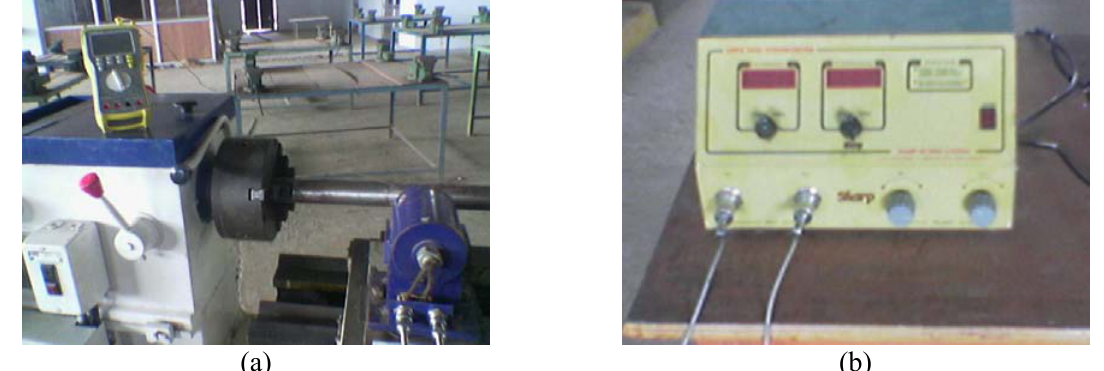
Fig. 1. Experimental setup (a) Turning tool dynamometer (b) Display channel for turning